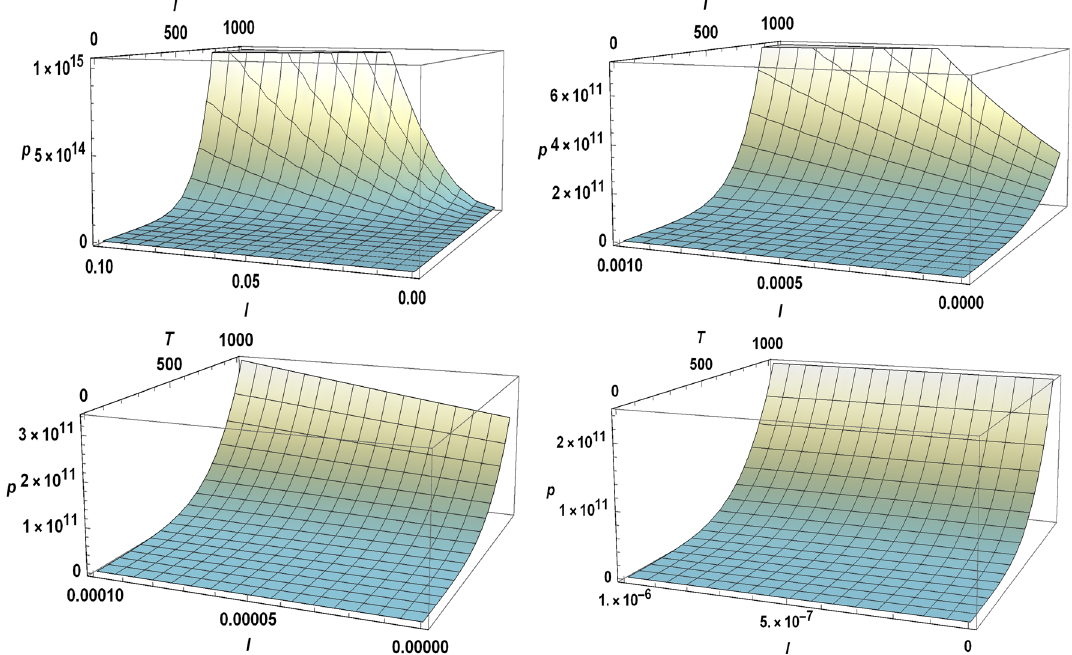
Fig. 13 The figure shows the equation of states for different values of p , T , and l ( whose dimension is m · kg − 1 / 2 · s − 1